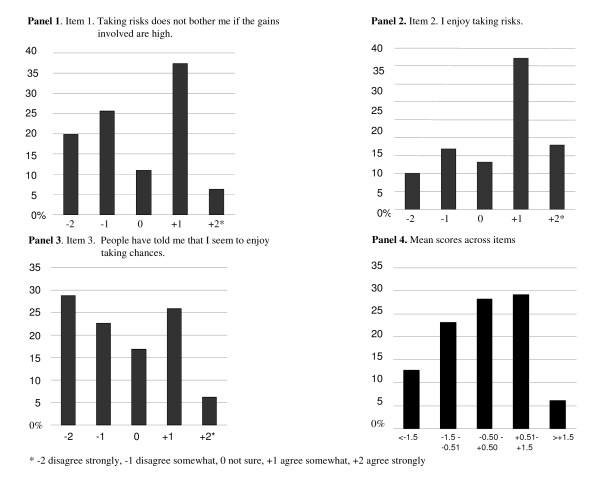
Distribution of Ratings for Jackson Personality Inventory Risk Attitude Items and Mean Scores Across Items.